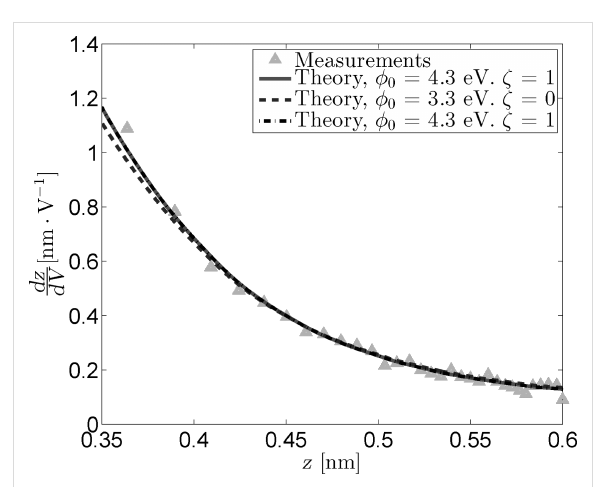
Figure 8: Measured and reconstructed dz / dV traces obtained from z ( V ) measurements for γ =0.5 . The masking effect between and ζ remains, but changes in these parameters do not significantly impact the effective barrier, leading to all reconstructed traces overlapping. The free parameter fit (solid line) leads to the maximum value for ξ (i.e., ξ = 1), causing the fitted parameters to be identical to those obtained from the fit with ξ fixed at its maximum value (dashdotted